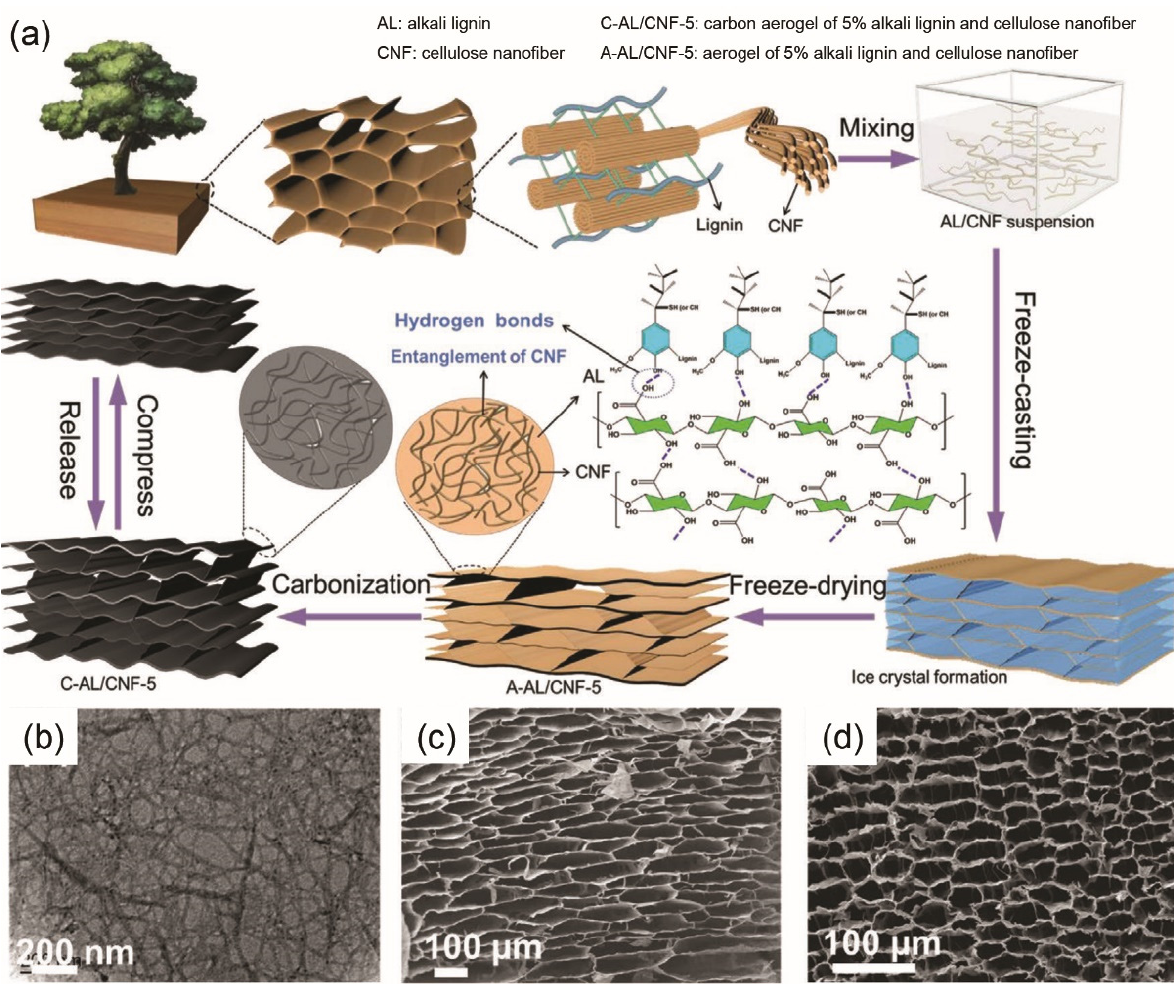
Figure 6. ( a ) Illustration of fabricating wood-derived C-AL/CNF-5; ( b ) Transmission electron microscope (TEM) image of CNF; Scanning Electronic Microscope (SEM) images of ( c ) A-AL/CNF-5 and ( d ) C-AL/CNF-5. C, A, AL, CNF represent carbon aerogel, aerogel, alkali lignin, cellulose nanofiber, respectively, and 5 indicates that the concentration of AL and CNF is 5%. ( a – d ) Reproduced with permission from ref. [62] Copyright 2020 John Wiley and Sons.